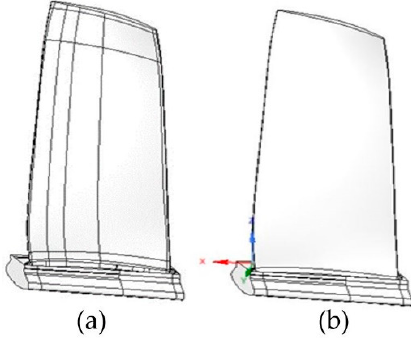
Figure 2. Computational solid model of axial compressor blade: ( a ) three-dimensional (3D) model from FARO Edge Arm, and ( b ) a simplified model.